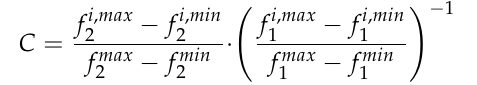
Figure 19. Residual load variance for the next three decades under scenarios: ( a ) RCP2.6, ( b ) RCP4.5, and ( c ) RCP8.5.